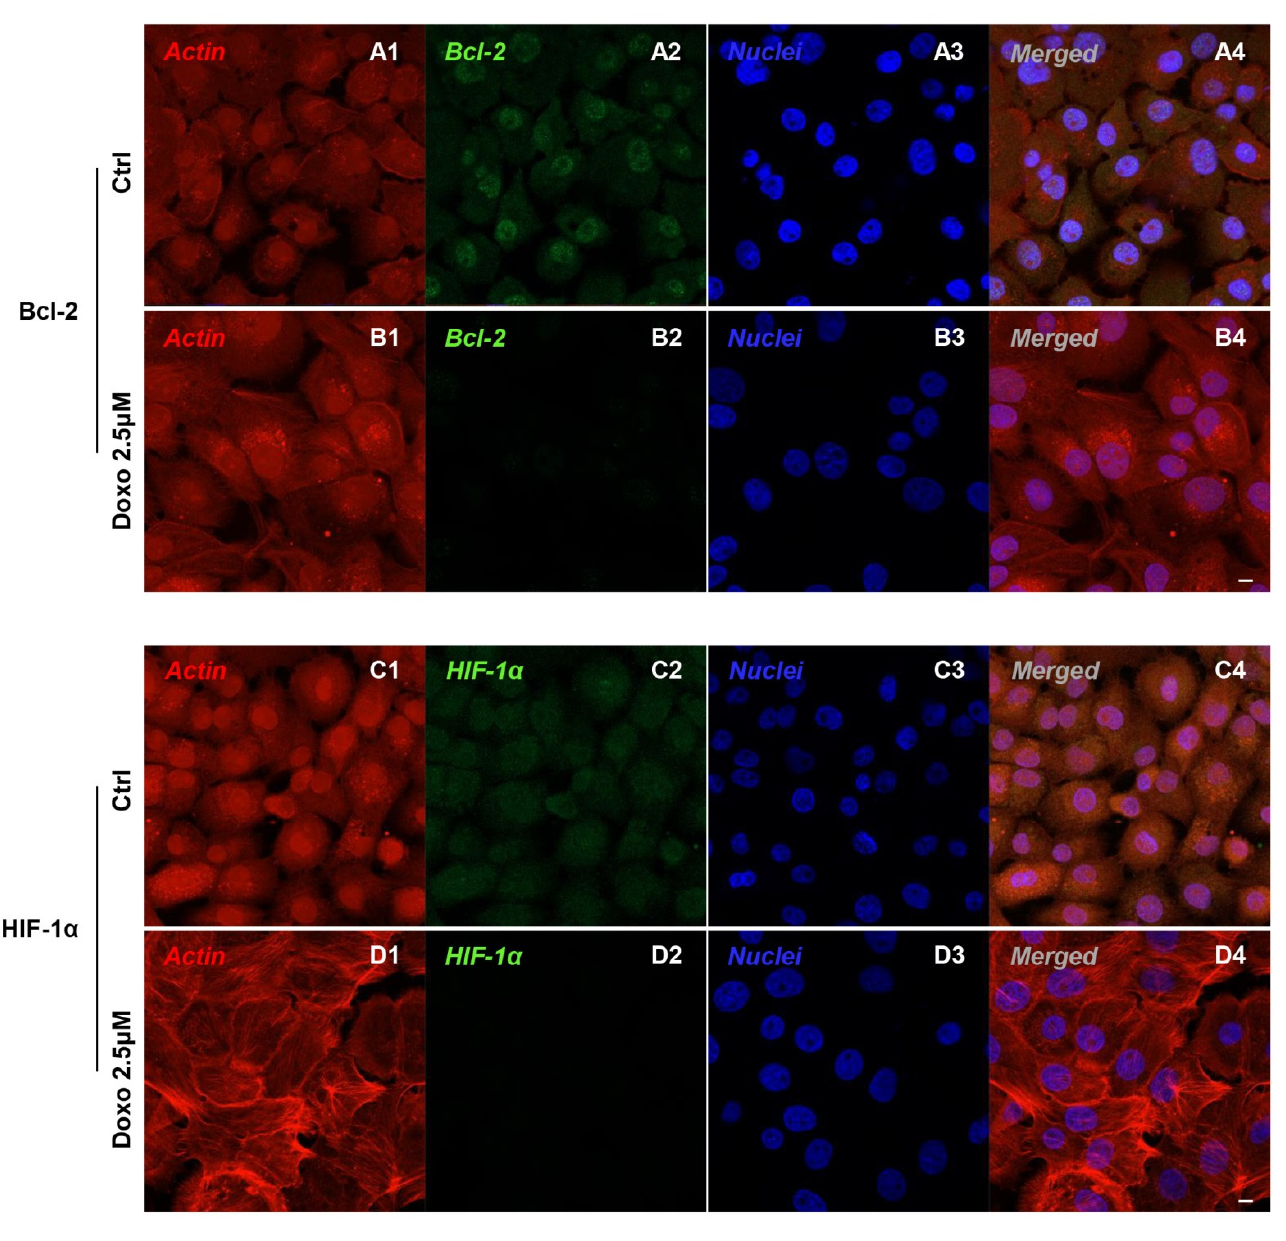
Figure 3. Confocal microscopic analysis on the expression of Bcl-2 and HIF-1 α in Cal-27 cell lines. Expression of Bcl-2 and HIF-1 α analyzed by confocal microscopy in untreated cells (CTRL) ( A1 – A4 , C1 – C4 ); expression of Bcl-2 and HIF-1 α expression in Cal-27 treated with Doxo 2.5 µM ( B1 – B4 , D1 – D4 ). Red fluorescence: cytoskeleton actin. Green fluorescence: Bcl-2 and HIF-1 α . Blue fluorescence: cell nuclei. Scale bar: 20 µm.